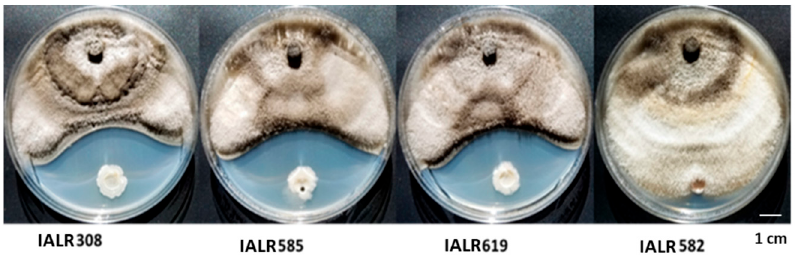
Figure 1. Endophytic bacterial inhibition of strawberry fungal pathogen C. gloeosporioides Cg58. The fungal pathogen was grown at 30 °C from 23 December 2020 to 13 January 2021.